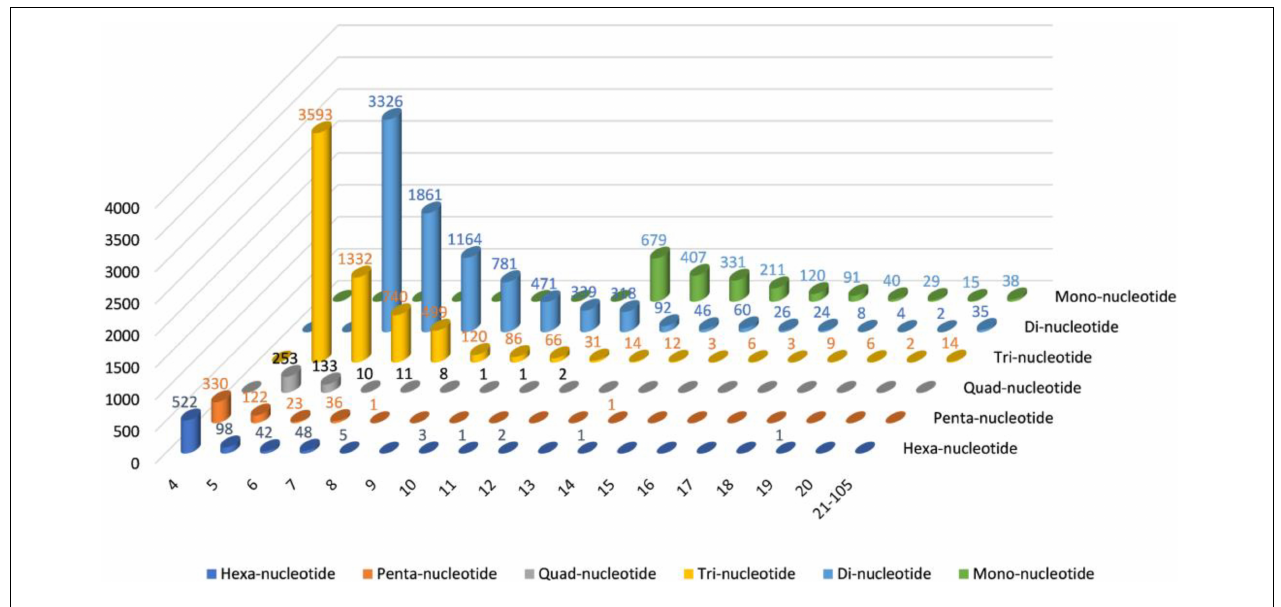
FIGURE 2 | The distribution of SSRs in Trapa bispinosa .